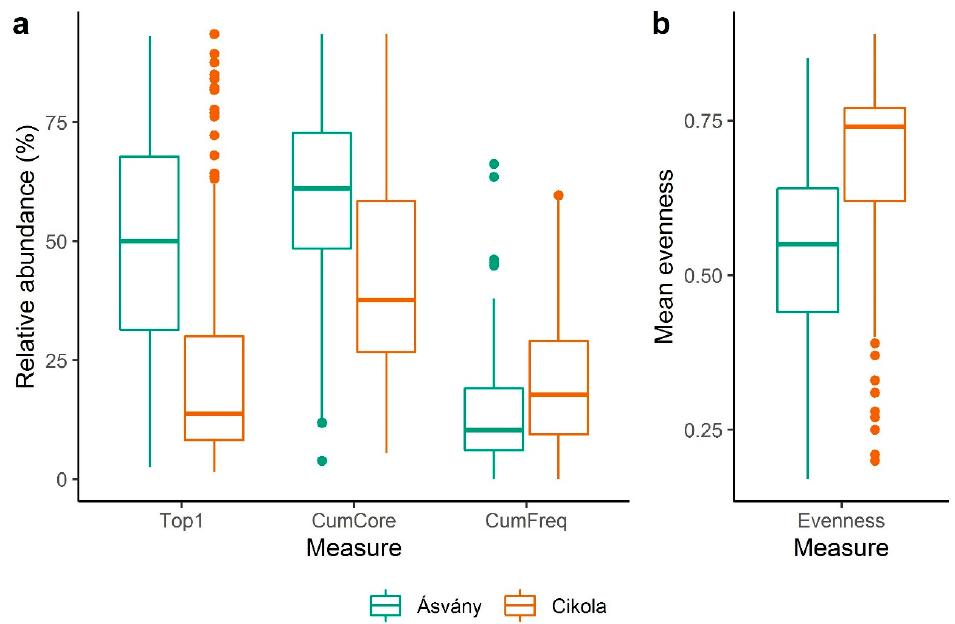
Figure 4. Relative abundance of Top1 species, cumulative core species (CumCor), cumulative common (CumFreq) species ( a ) and evenness ( b ) at points c5 and c6 of the Cikola tributary system on deployed reeds and natural reeds (orange) and at points a4 and a6 in the deployed reeds and natural reeds of the Ásvány tributary system (green).